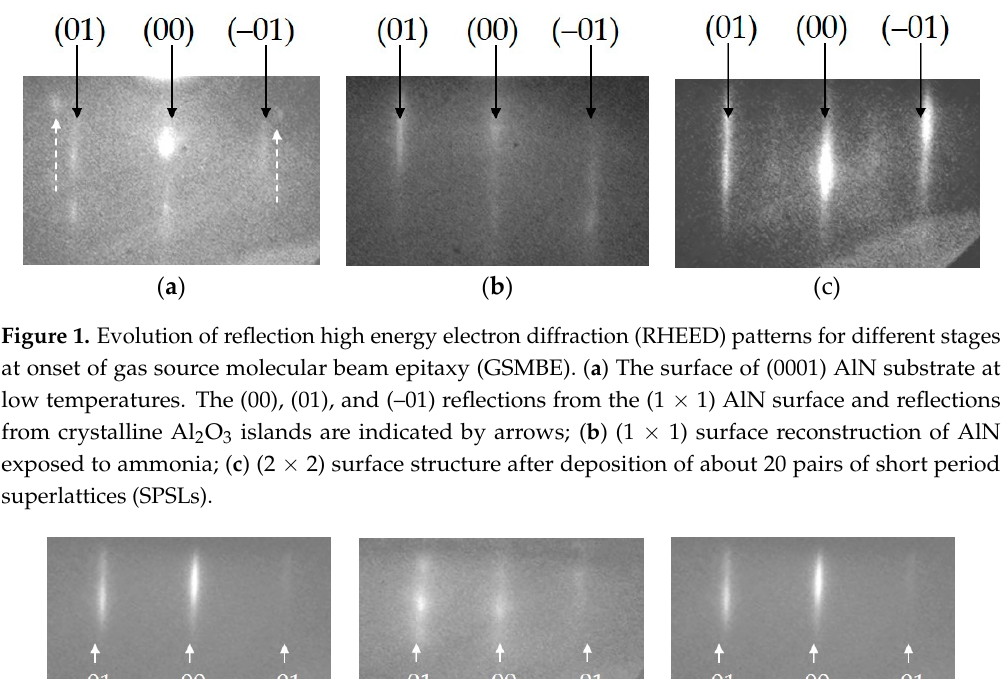
(c) Figure 1. Evolution of reflection high energy electron diffraction (RHEED) patterns for different stages at onset of gas source molecular beam epitaxy (GSMBE). ( a ) The surface of (0001) AlN substrate at low temperatures. The (00), (01), and (–01) reflections from the (1 × 1) AlN surface and reflections from crystalline Al 2 O 3 islands are indicated by arrows; ( b ) (1 × 1) surface reconstruction of AlN exposed to